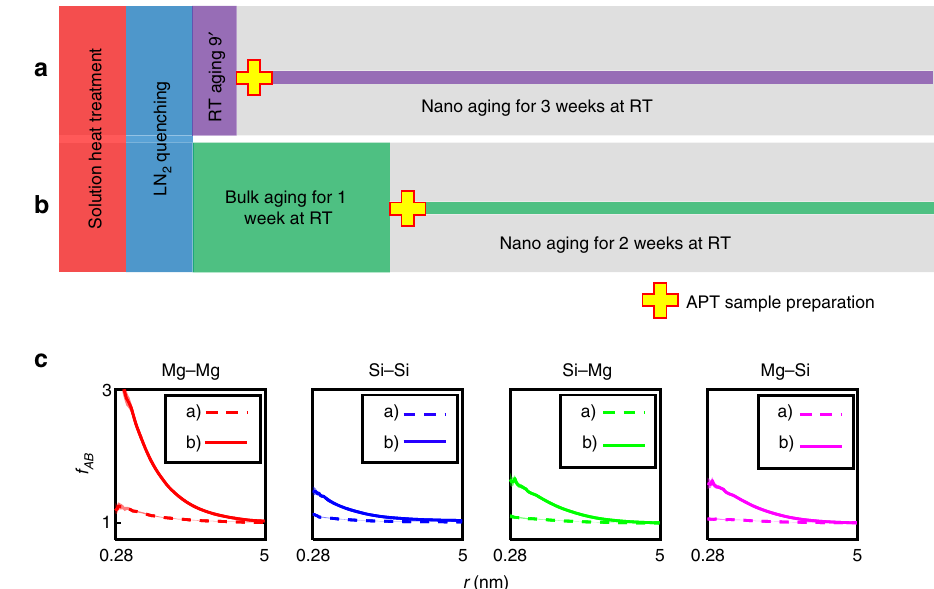
Fig. 4 Bulk natural aging of quenched AlMgSi alloy. The schematic overview of the heat treatment and sample preparation procedure illustrates that the total time after quenching is kept constant at three weeks, while solely the time of preparation of the nano-sized atom probe specimen was varied, a 9 min vs. b 1 week. c Analysis of the spatial positions of the solute atoms for a 9 min of bulk aging and 3 weeks of nano aging and b 1 week of bulk aging and 2 weeks of nano aging. A pronounced difference is observed although the total time after quenching, Δ t NA , is similar and only the time at bulk dimensions has been varied. For the long natural aging at bulk dimensions the expected strong solute clustering upon natural aging is obvious. Error bar boundaries are calculated according to Supplementary Eqs. (7) and